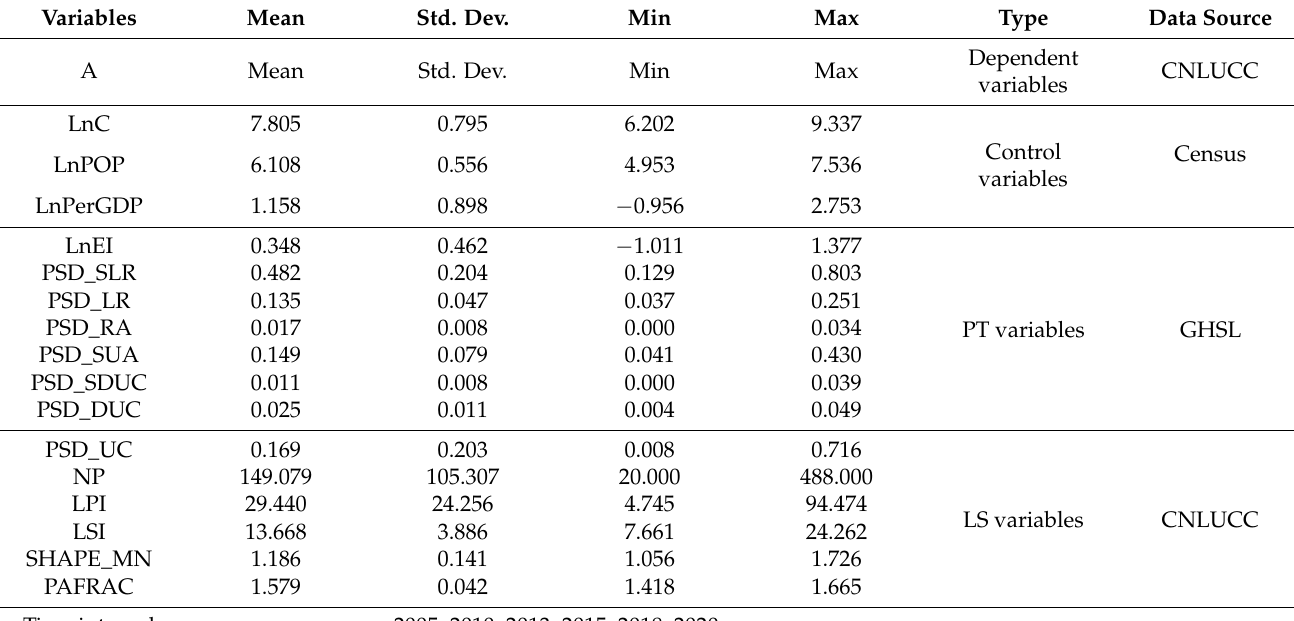
Table 3. Descriptive statistics of